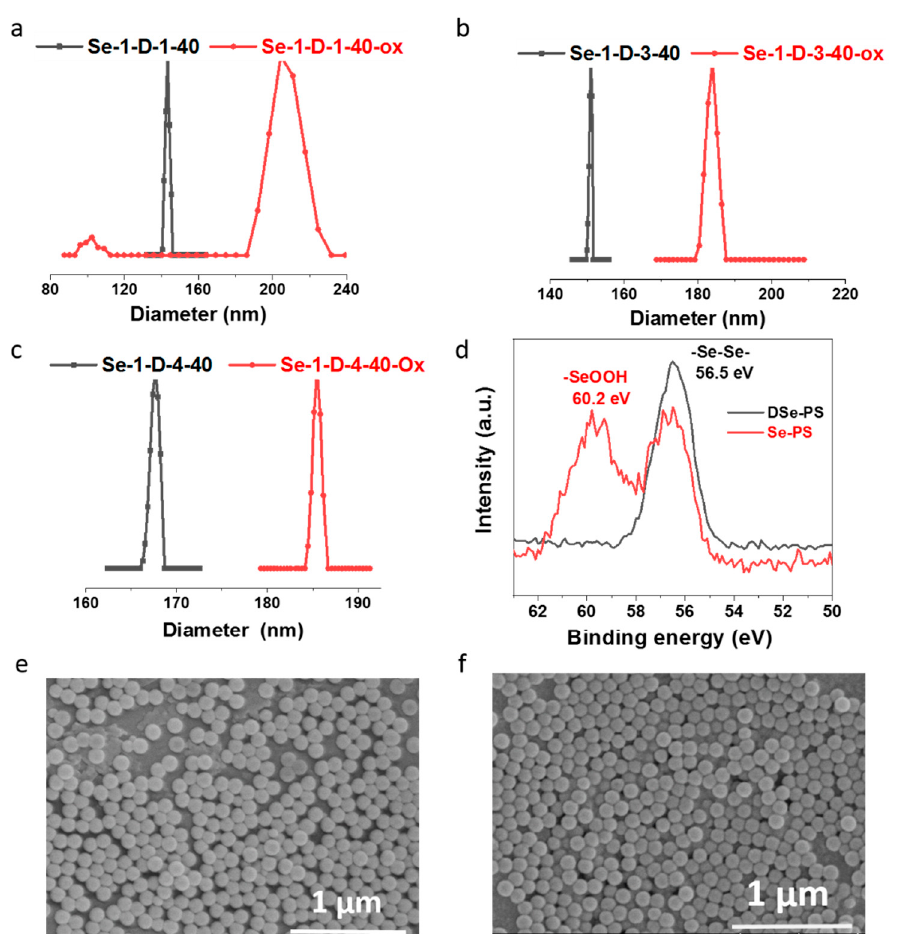
Figure 3. Particle size distribution curve of DSe-PS before and after oxidation by H 2 O 2 (black-before oxidation; red-after oxidation). ( a ) Se-1-D-1-40, ( b ) Se-1-D-3-40, ( c ) Se-1-D-4-40. ( d ) XPS spectra of Se in DSe-PS and Se-PS which was oxidized by 5 wt% H 2 O 2 overnight. SEM images of Se-1-D-3-40 ( e ) before and ( f ) after oxidation.